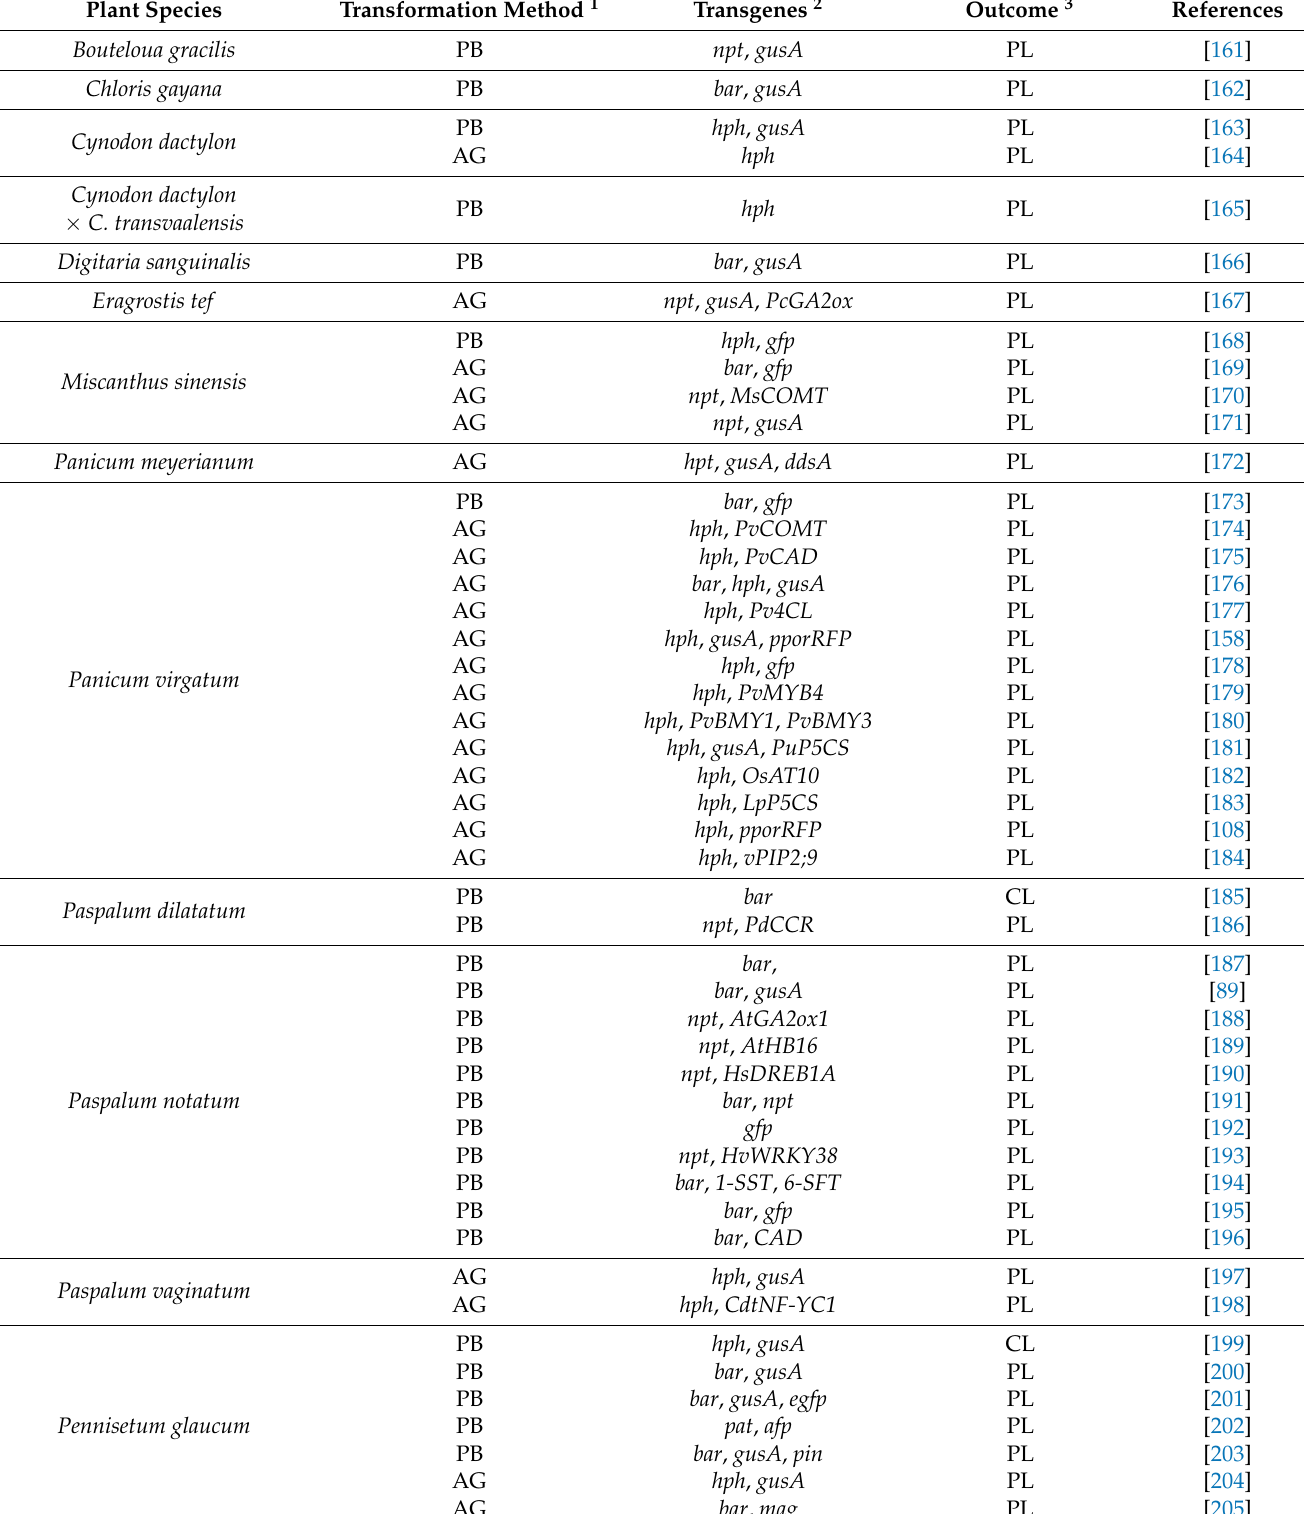
Table 2. Summary of genetic transformation in warm-season